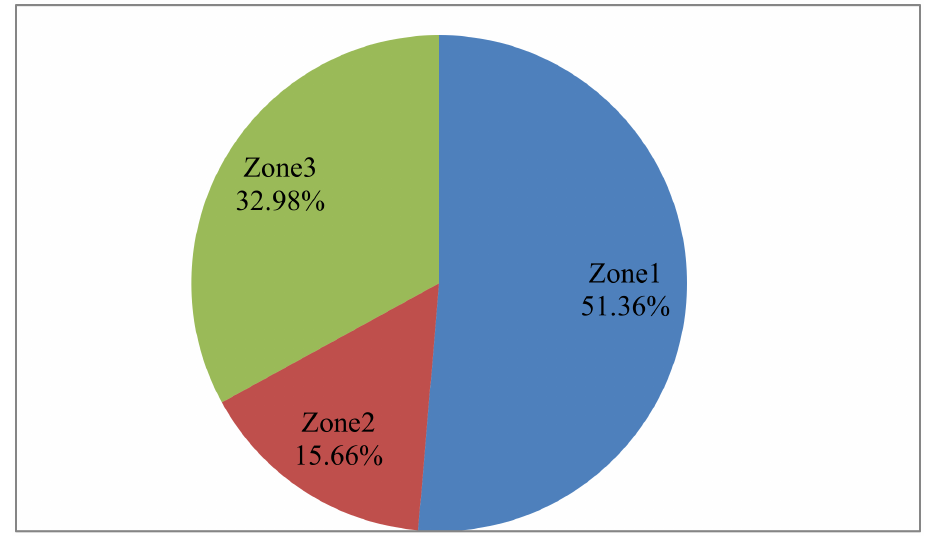
Figure 2. Electricity consumption in each zone.